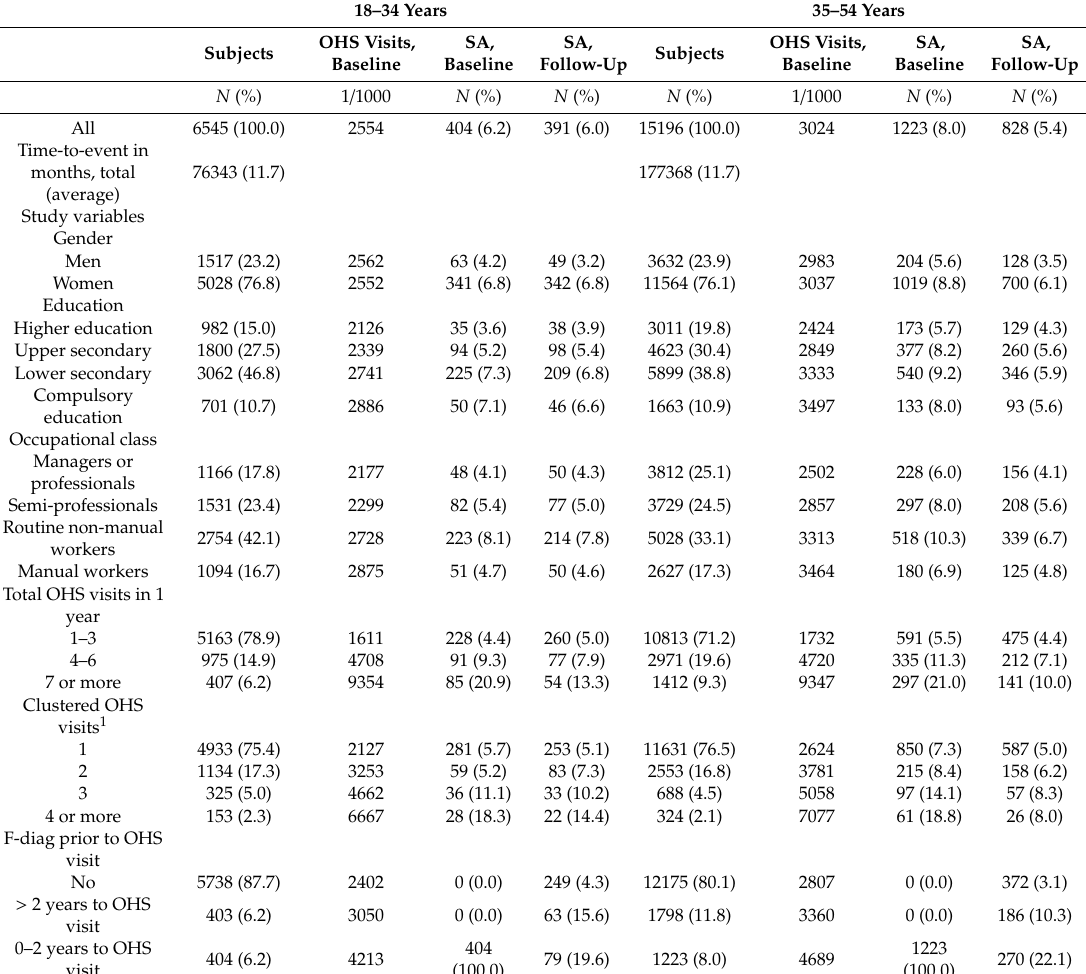
Table 1. Distributions of study variables, means of occupational health service (OHS) visits at baseline and sickness absence (SA) at baseline and during the follow-up among the employees of the City of Helsinki, by age